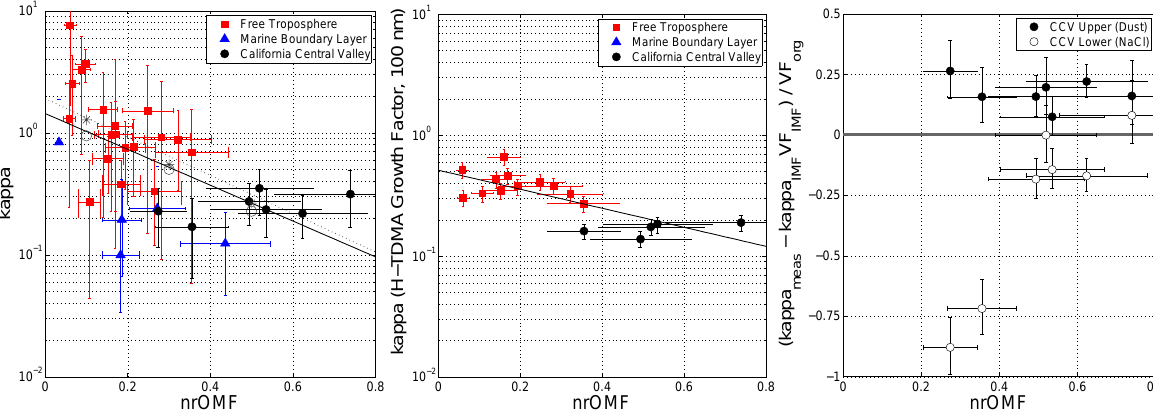
Fig. 6. κ vs. non-refractory organic mass fraction (nrOMF). The left panel shows κ values calculated using CCN and size distribution measurements. Error bars for κ were calculated by computing the certainty in the calculated dry critical diameter ( d pc ) using the variability in the SMPS size distributions and CCN measurements ( σn − 0 . 5 ) for each flight leg; the uncertainty d pc was propagated with the supersaturation error (20%) to yield the κ error. Error bars for the nrOMF were calculated from the variability in the AMS nrOM during the flight leg ( σn − 0 . 5 ) , combined in quadrature with a 20% uncertainty typically associated with AMS nrOM measurements and 15% associated with aerosol volume (SMPS). The lines indicate the best fit line to all data (black) and omitting MBL data (grey). Grey circles (all data) and grey asterisks (omitting MBL) are binned averages for nrOMF ranges 0–0.2, 0.2–0.4, and 0.4–0.6. The middle panel shows κ values calculated using H-TDMA growth factor measurements for particles of size 100nm (error: ± 15%). The right panel shows the difference of measured κ and the κ calculated using inorganic components only (normalized to the organic volume fraction, VF org ) , an estimate of κ org (see text for details). Y-axis error bars shown here are κ meas /VF org